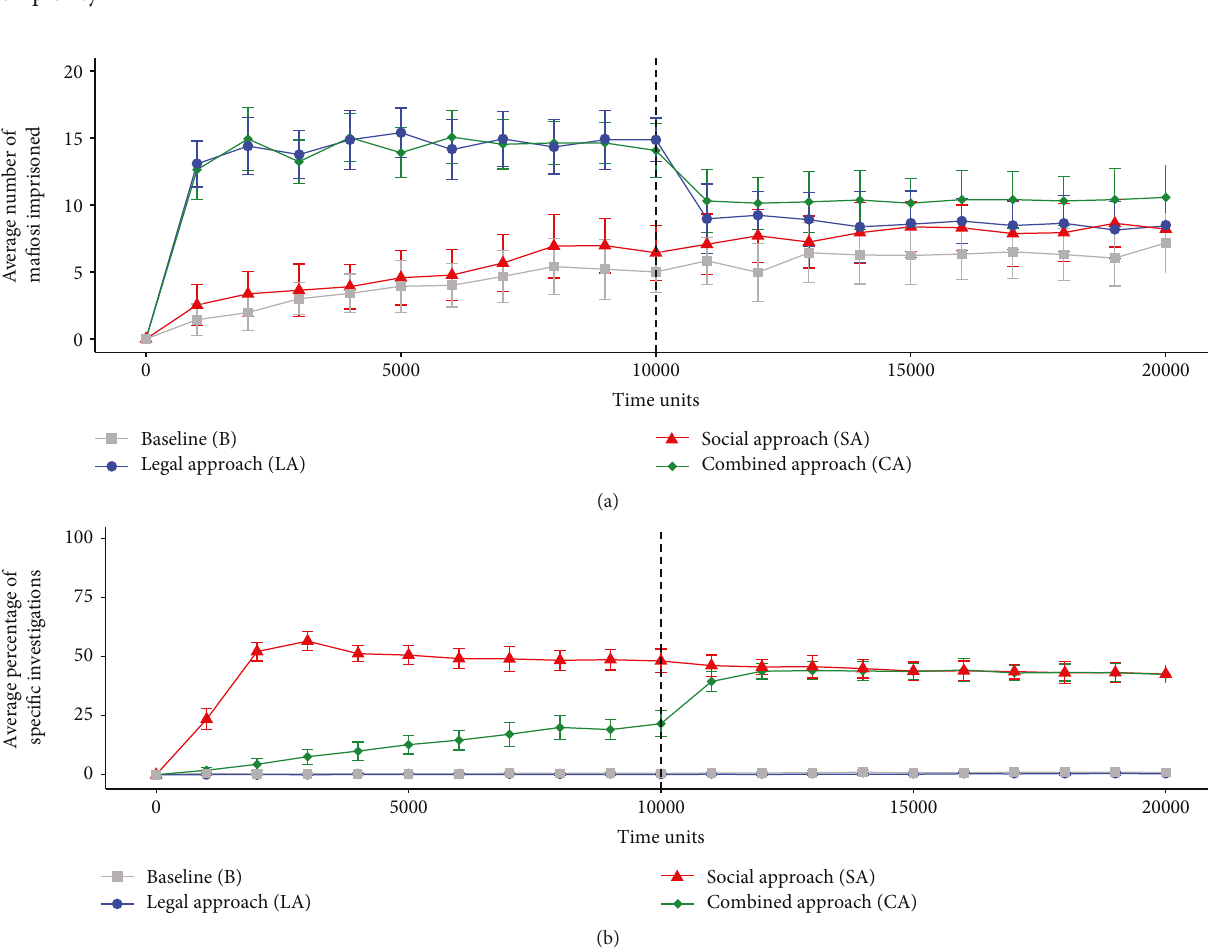
Figure 3: Ma fi a imprisonment. Means plotted and error bars indicate ± 1 standard deviation. (a) The number of ma fi osi (out of 20) imprisoned in each treatment and (b) proportion of investigations that are speci fi c investigations. The dashed line indicates the change to baseline